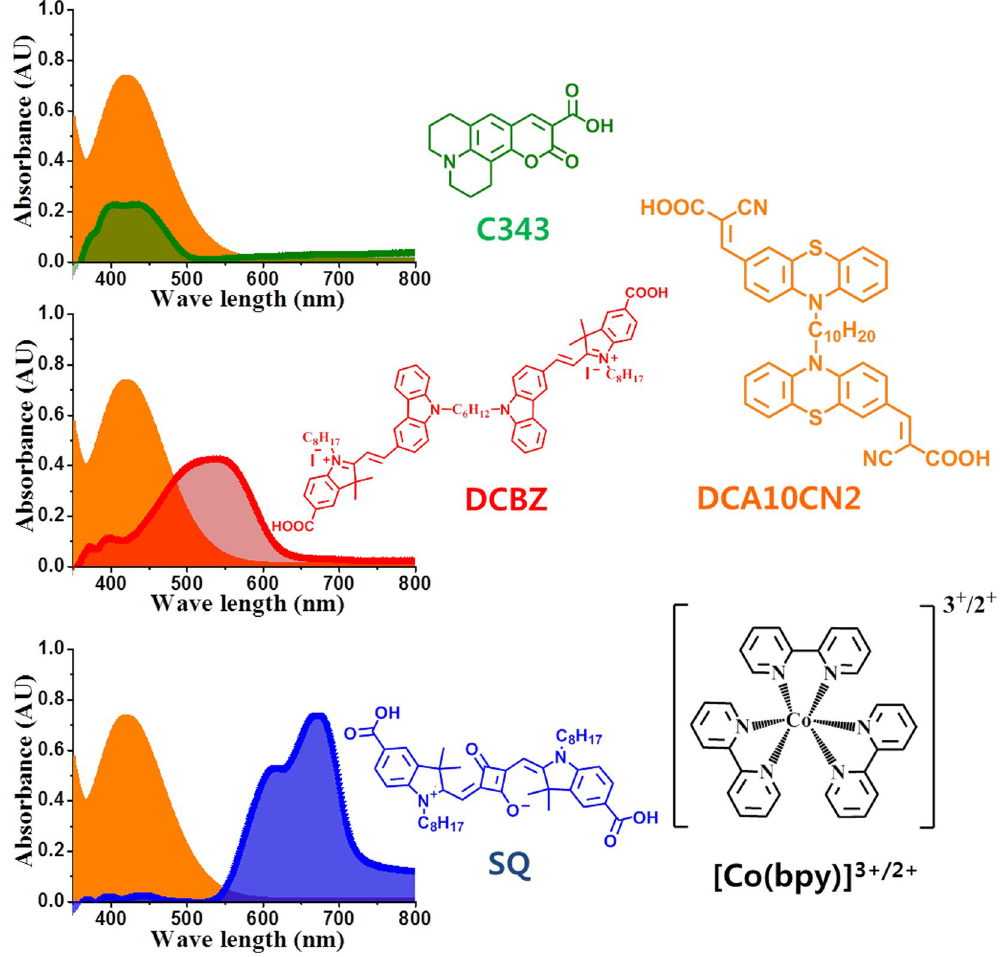
Figure 2. Pictorial representation of complementary absorption spectra of the dyes used in this study and chemical structures. Absorption spectrum of n-type DCA10CN2 overlapped with those of C343, DCBZ, and SQ p-type dyes with molecular structure along with molecular structure of cobalt